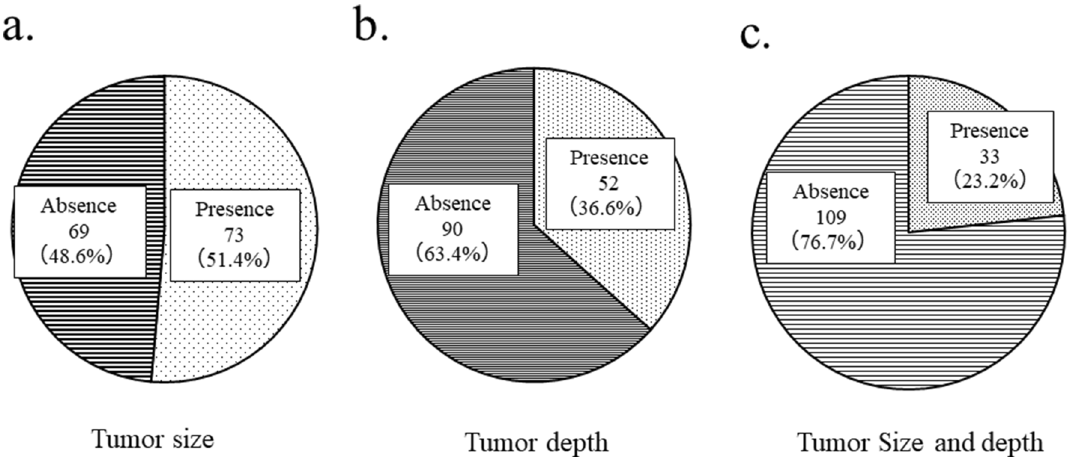
Figure 1. Description of tumor information in the patient referral document. ( a ) Tumor size was described in 73 cases (51.4%). ( b ) Tumor depth was described in 52 cases (36.6%). ( c ) Both tumor depth and size were described in 33 cases